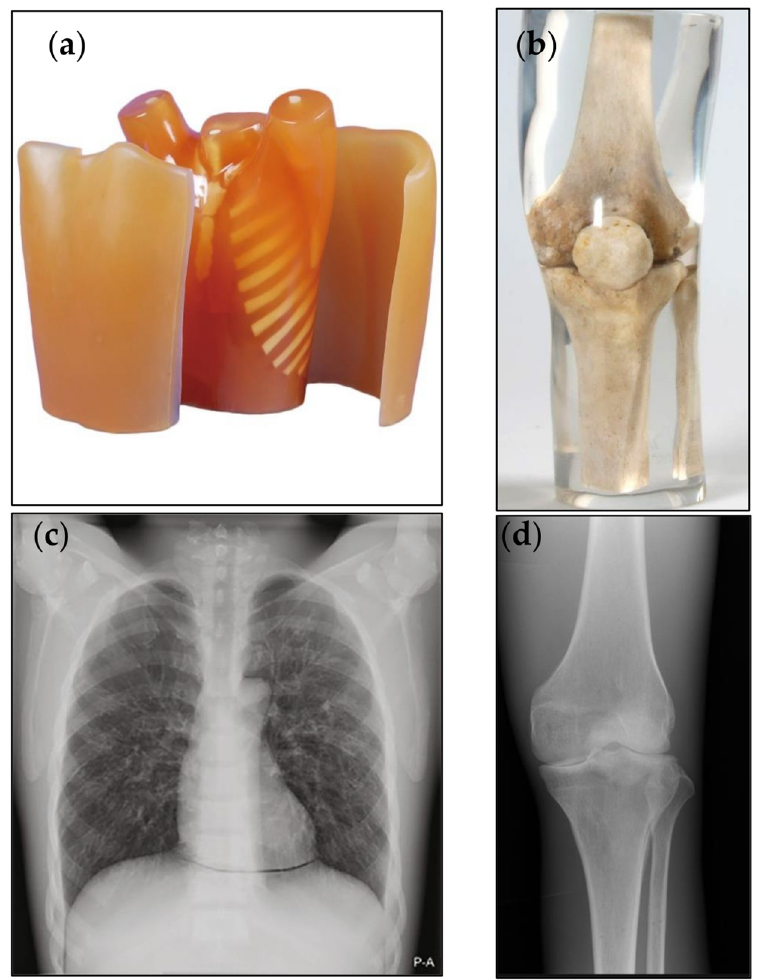
Figure 1. The frontal view of ( a ) photographic image of the chest anthropomorphic phantom ( b ) photographic image of the knee phantom ( c ) radiographic image of the chest anthropomorphic phantom and ( d ) radiographic images of the knee phantom .